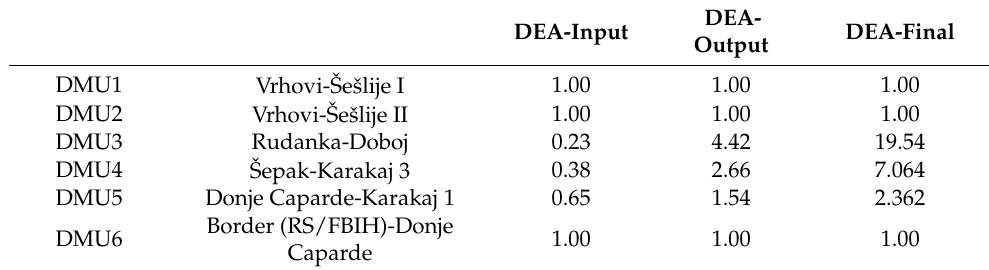
Table 8. Results of the safety situation on road sections after the application of the DEA model.